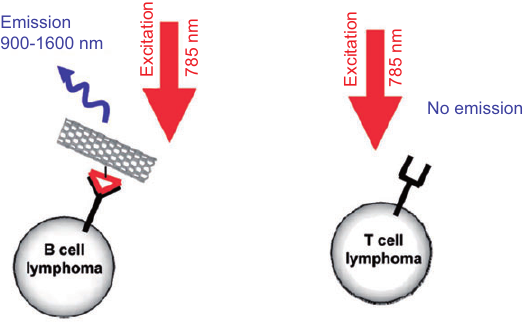
Figure 18 Schematic of NIR photoluminescence (PL) detection of SWNT-Rituxan conjugates selectively bound to CD20 cell surface receptors on B-cell lymphoma (left). The conjugates are not recog- nized by T-cell lymphoma (right) [119] . Reprinted with permission from Ref. [119] . Copyright (2008) American Chemical